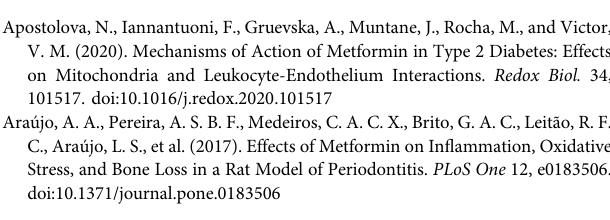
Supplementary Figure S2 | Effect of metformin on COX1 and COX2 expression. Gene expression of mitochondrial enzymes COX1 and COX2, with tendency of downregulation